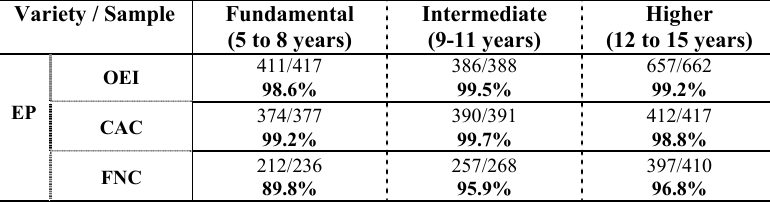
Table VII: Third person plural verbal marking in EP and Education Variety /